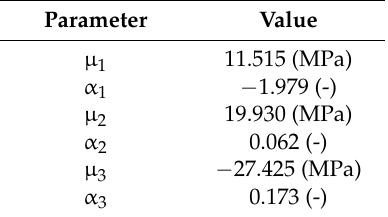
Table 2. Ogden hyperelastic model parameter values fitted from experimental data.